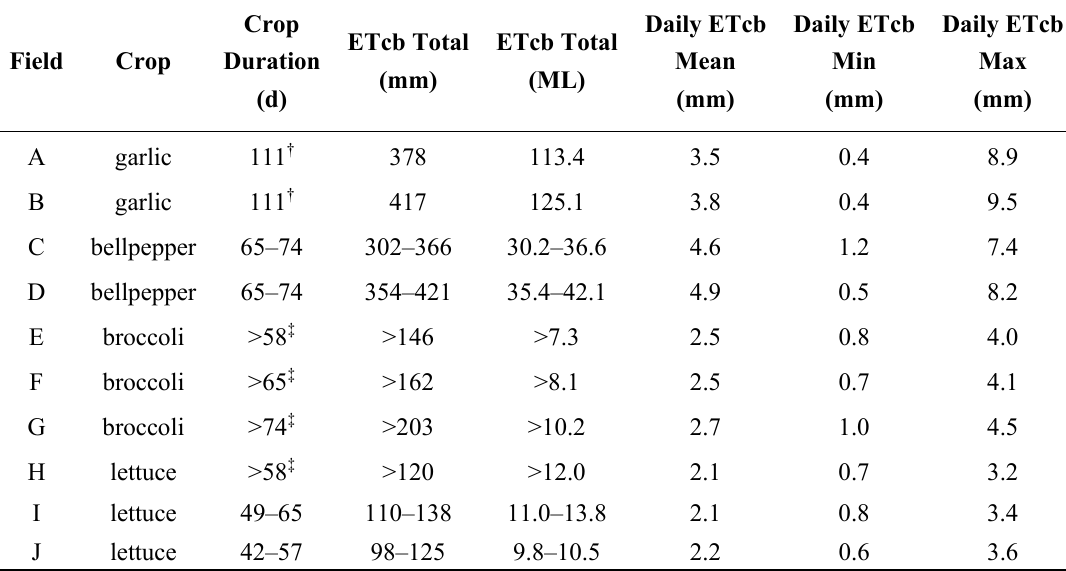
Table 4. Satellite observations of crop cycle duration from development start to harvest, and associated estimates of daily and total basal crop evapotranspiration. Total ETcb shown in terms of both water depth (mm) and volume (ML), which is a product of water depth and field size.